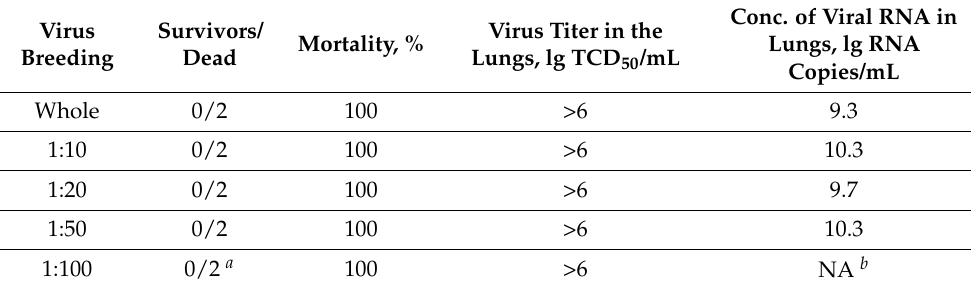
Table 4. Determination (MLD) of the minimum lethal dose (MLD50) in mice infected with the SARS-CoV-2 Vero «Dubrovka»